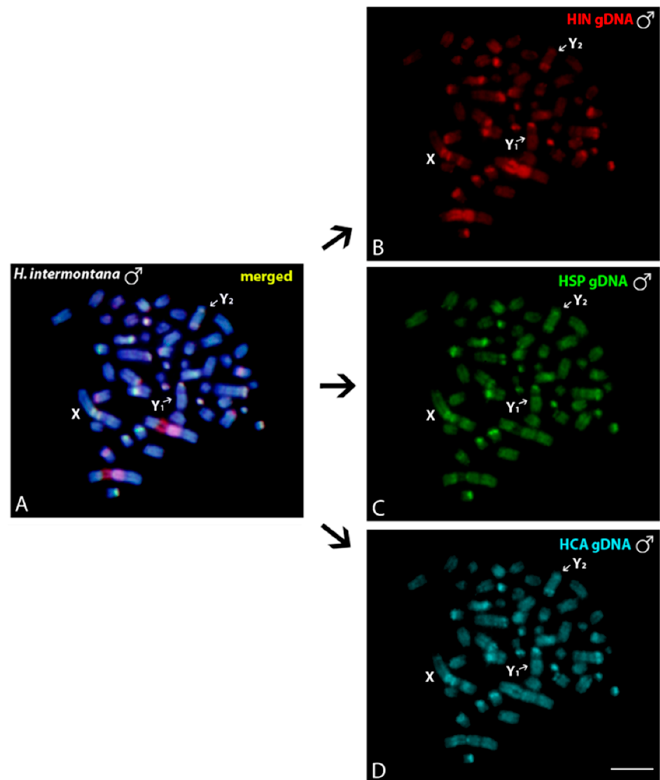
Figure 5. Mitotic chromosome spreads of males from H. intermontana ( A – D ) after comparative genomic hybridization (CGH): interspecific hybridizations probed with a male-derived genomic probe from H. intermontana ( B ), Harttia sp. 1 ( C ), and H. carvalhoi ( D ). ( A ) depicts the merged images of the genomic probes and DAPI staining. The common genomic regions for male and female are depicted in yellow. Sex chromosomes are indicated. Bar = 10 μ m.